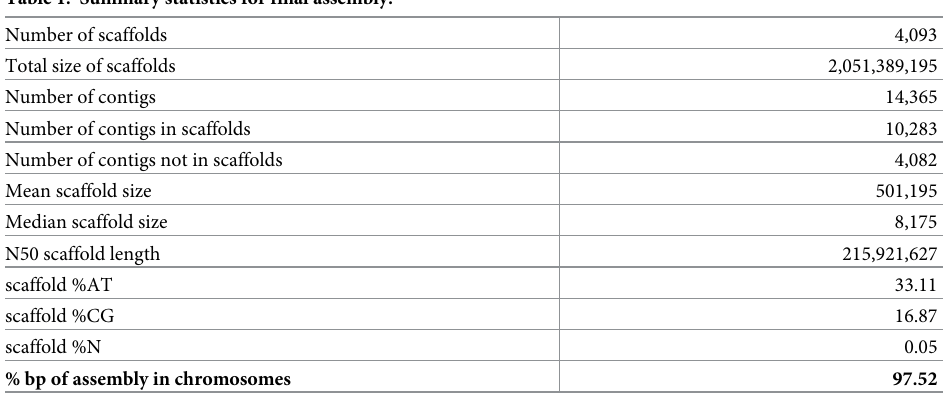
Table 1. Summary statistics for final